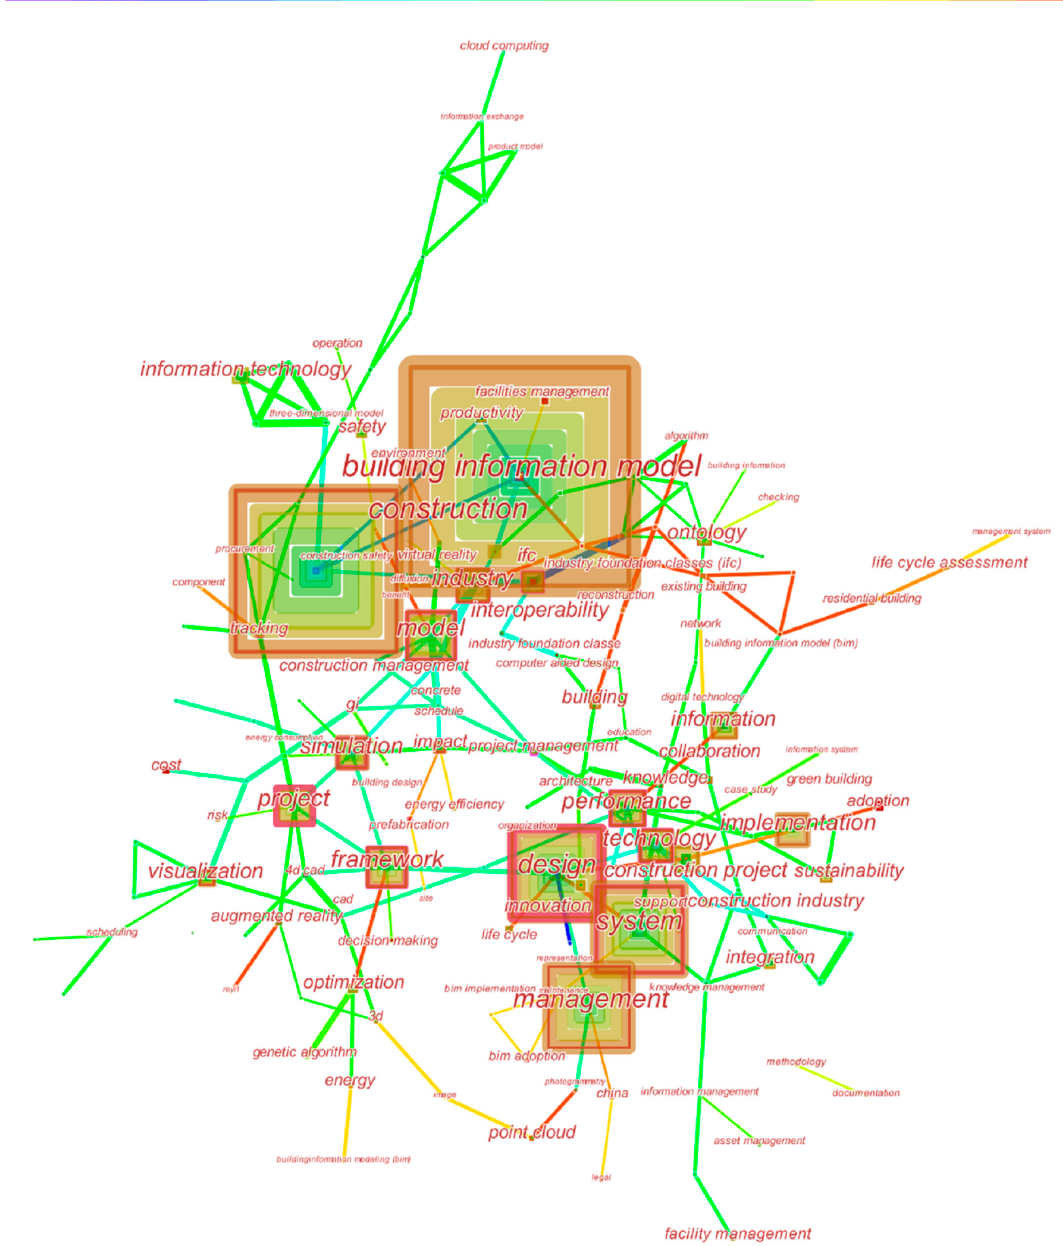
Figure 8. Network of co-occurring keywords.